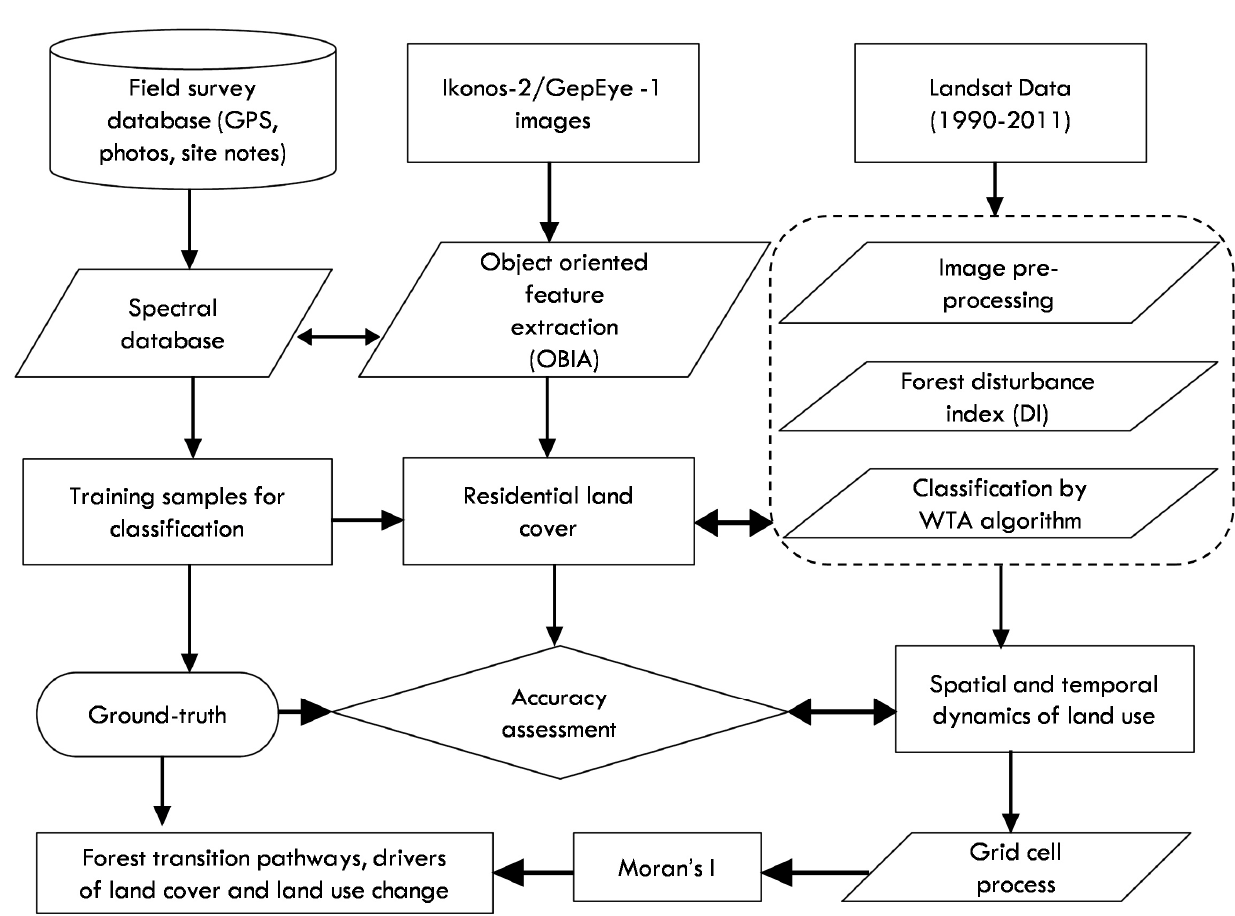
Figure 2. Overall workflow of the